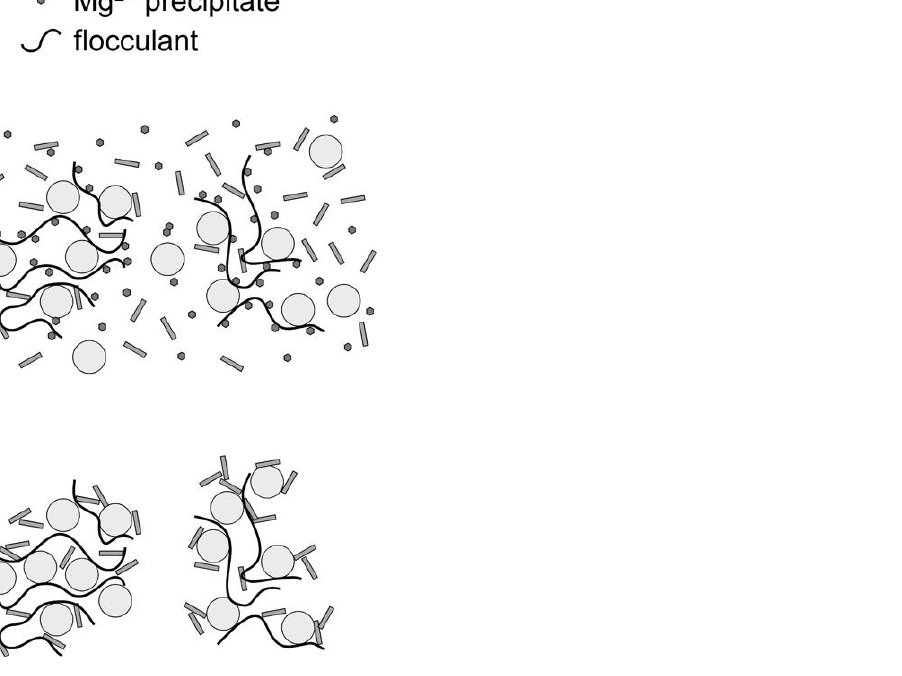
Figure 9. Schematic representation of aggregate formation in synthetic tailings containing quartz and kaolin. ( A ): flocculation in Rsw, ( B ): flocculation in Tsw.